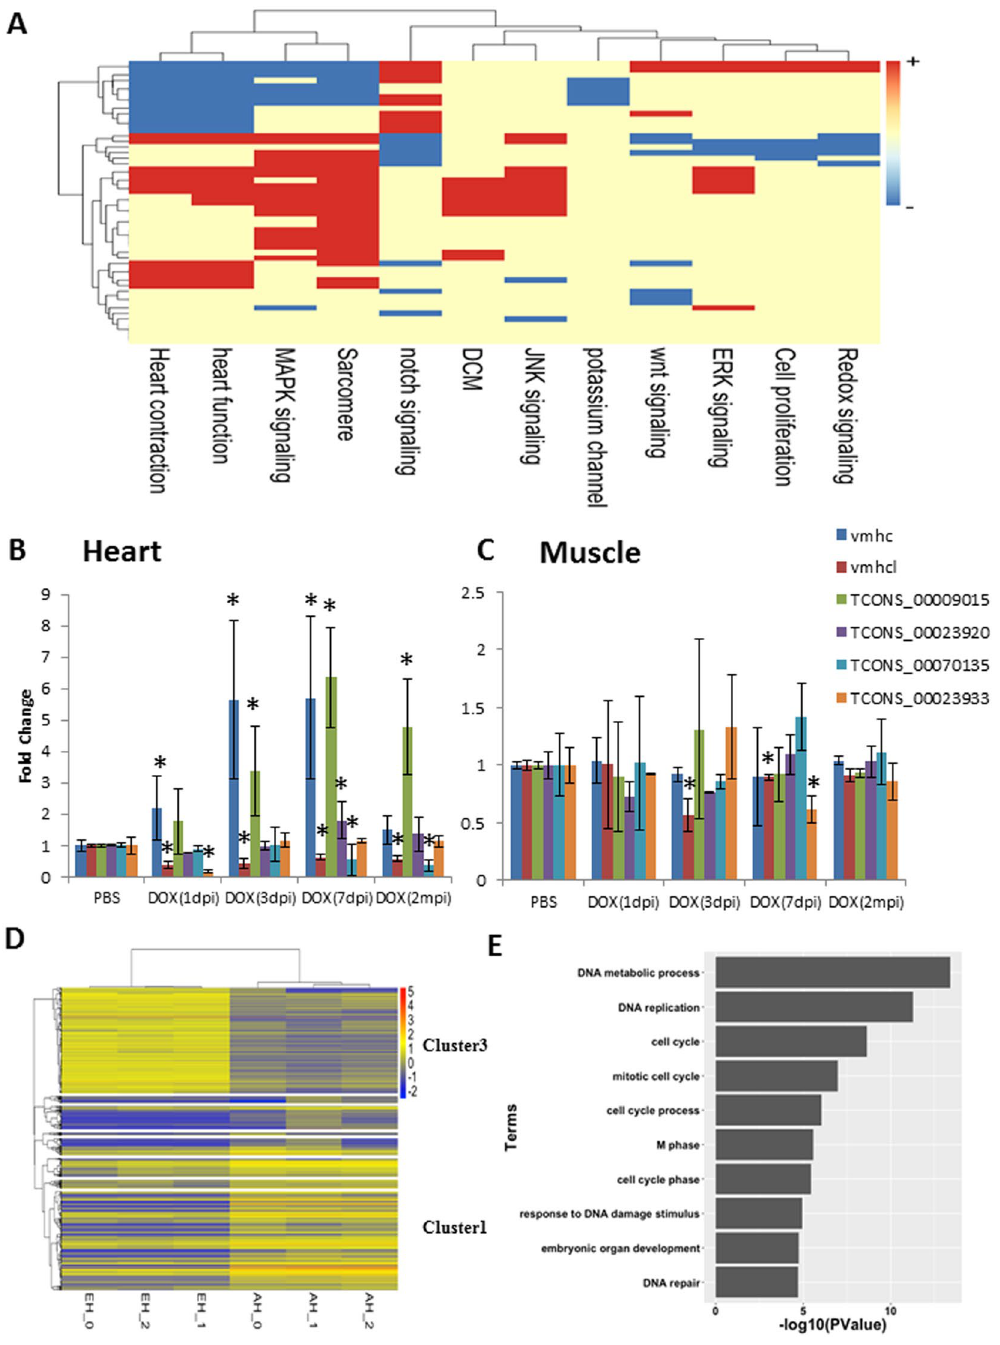
Figure 7. Analysis of fetal lincRNAs. ( A ) Expression-based association matrix of 51 fetal lincRNA transcripts (rows) and functional gene sets (columns). Red, positive correlation; blue, negative correlation; yellow, no correlation. Expression of fetal lincRNAs upon DOX stress in adult heart and muscle. Quantification of expression level change of lincRNAs upon DOX stress in the heart ( B ) and in the muscle ( C ). Means ± S.D. N = 5. * P < 0.05 compared to control (PBS) group. Ratio of vmhc to vmhcl served as cardiac remodel marker. ( D ) K-means clustering for all differentially expressed transcripts including protein-coding transcripts and lincRNAs. ( E ) Gene functional enrichment analysis of protein-coding genes in Cluster 3 suggested that fetal lincRNAs (all grouped into Cluster 3) were significantly enriched in several biological processes including DNA metabolic processes, DNA replication, and cell cycle (FDR <